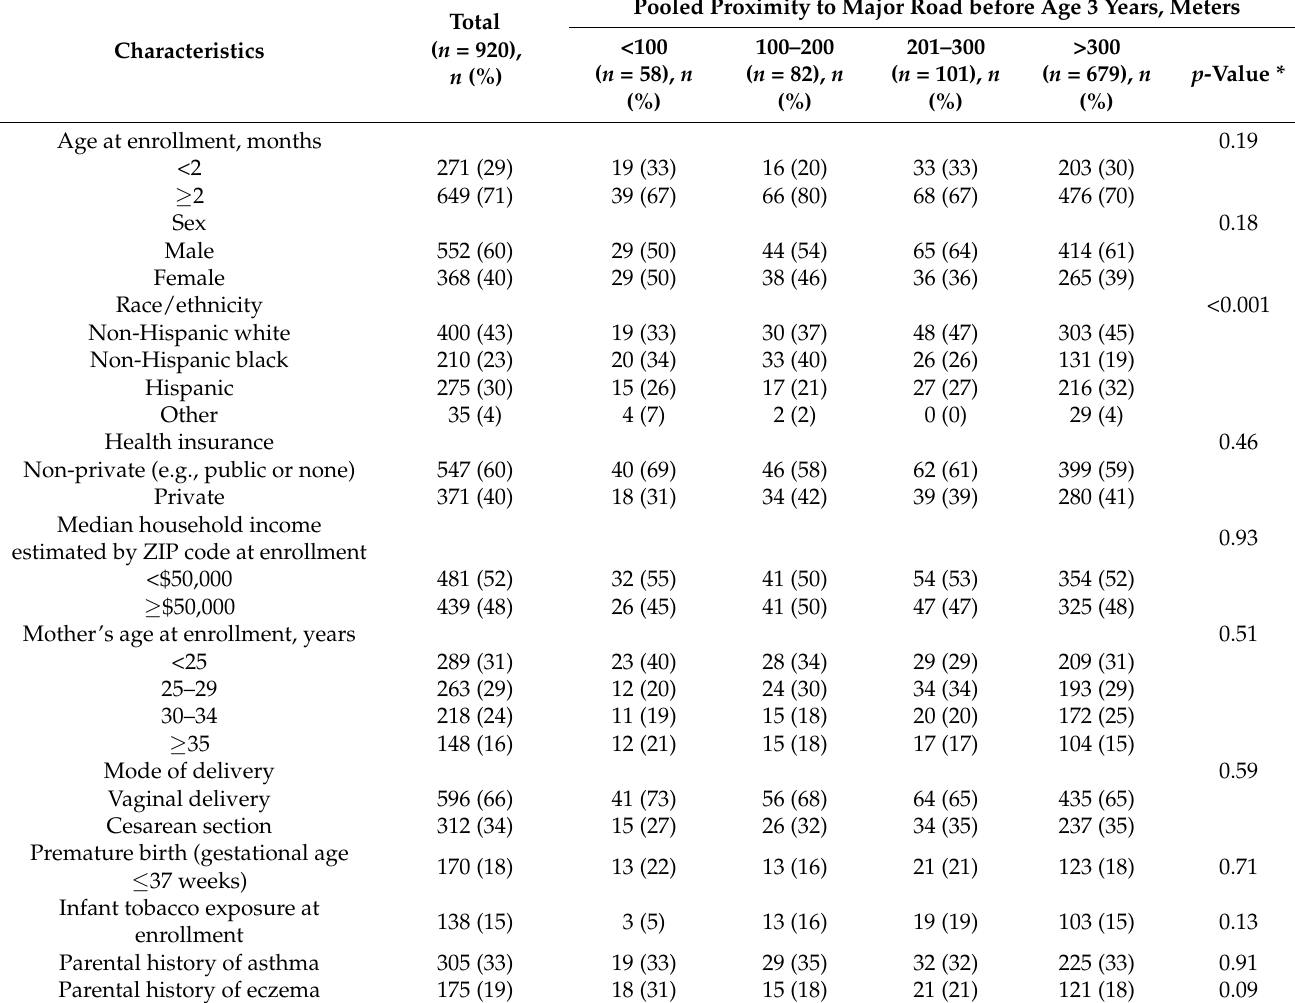
Table 1. Participant characteristics by categories of pooled proximity to major roads before age 3